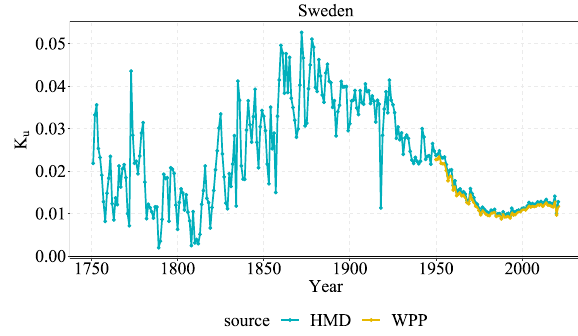
Fig. 7 K u value in Sweden from HMD and WPP,